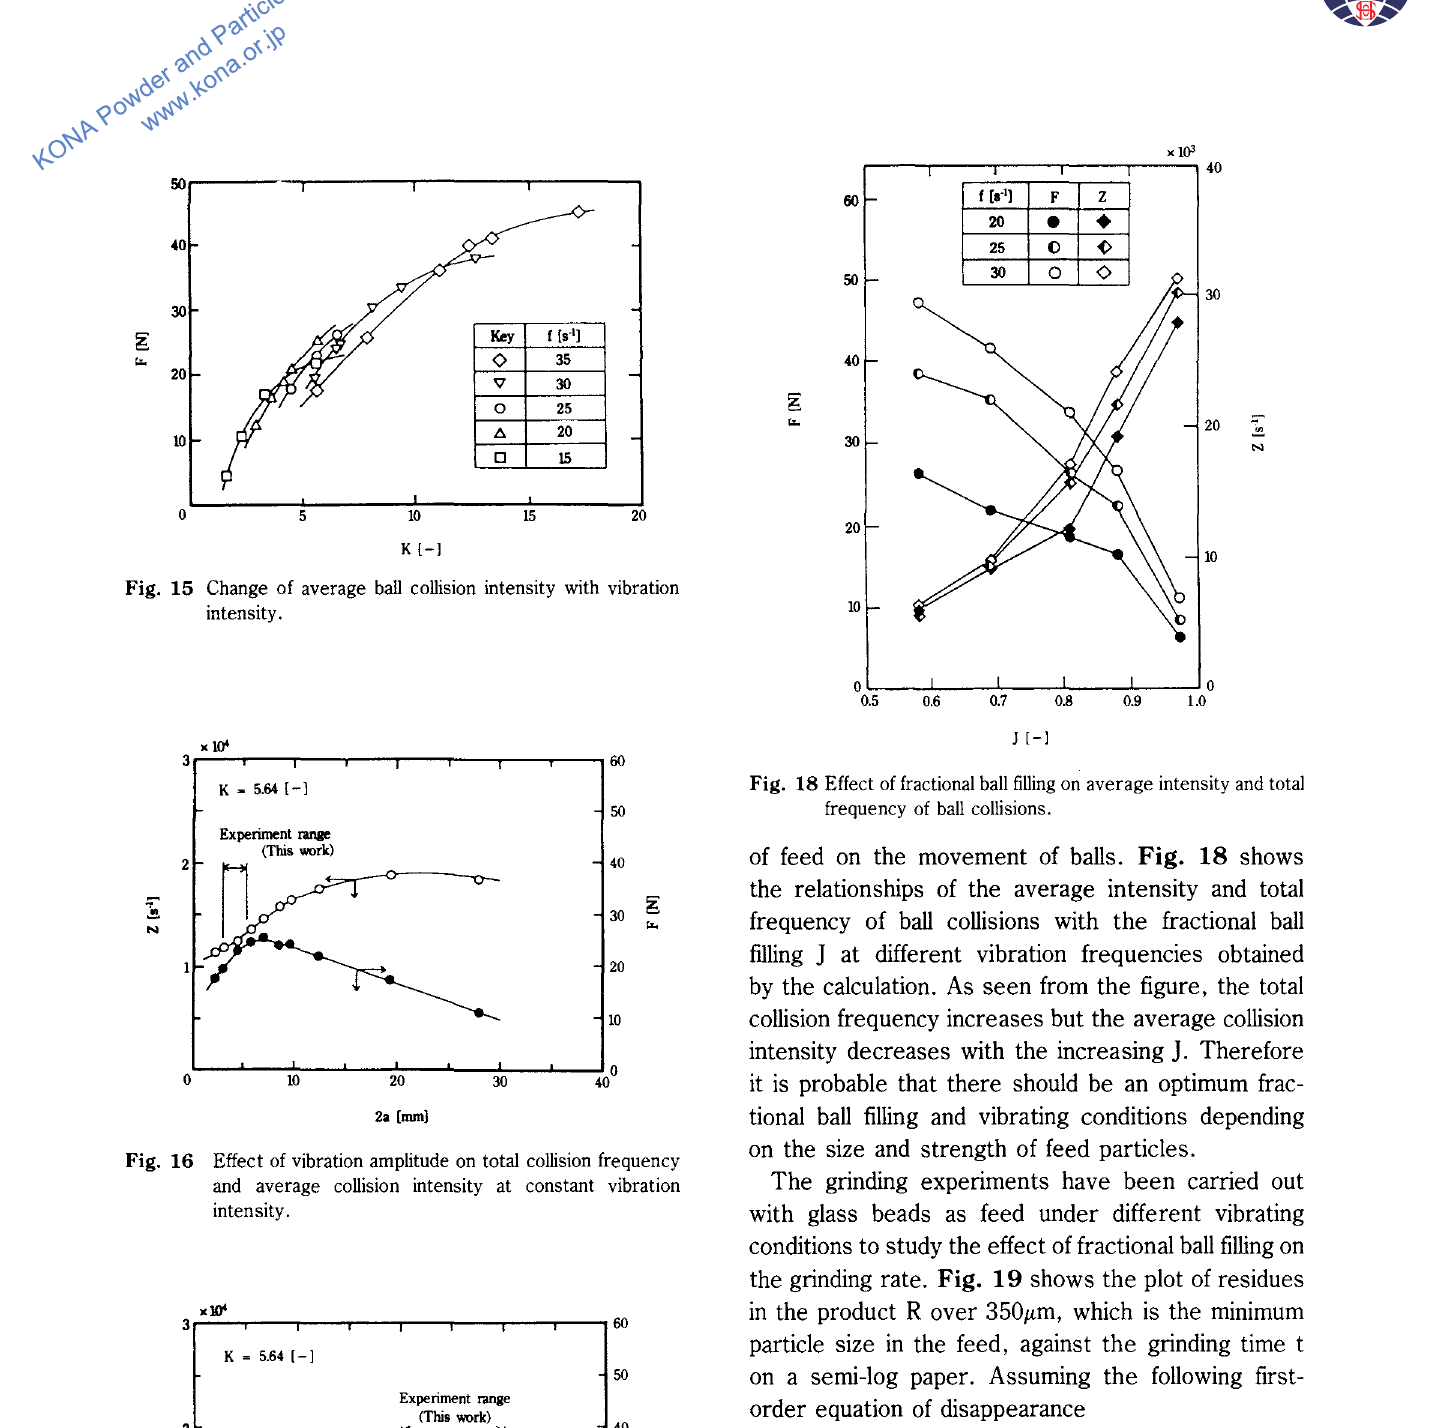
Fig. 17 Effect of vibration frequency on total collision frequency and average collision intensity at constant vibration intensity.